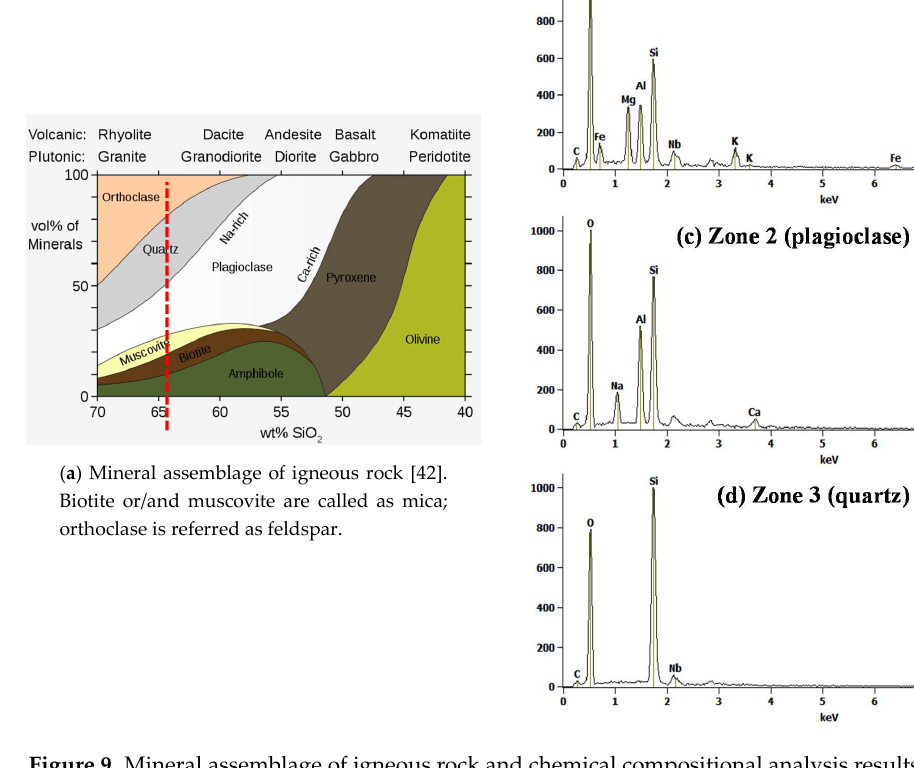
Figure 9. Mineral assemblage of igneous rock and chemical compositional analysis results.